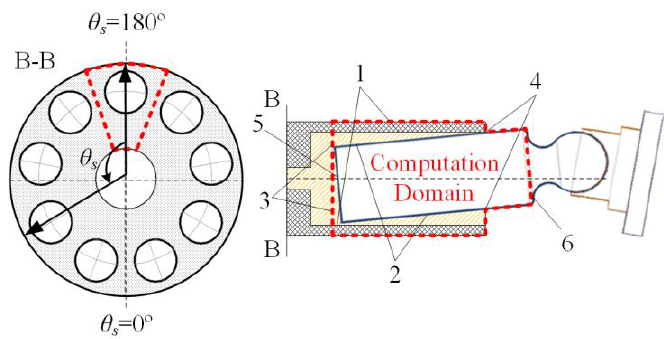
Figure 3. Computation domain and boundary.